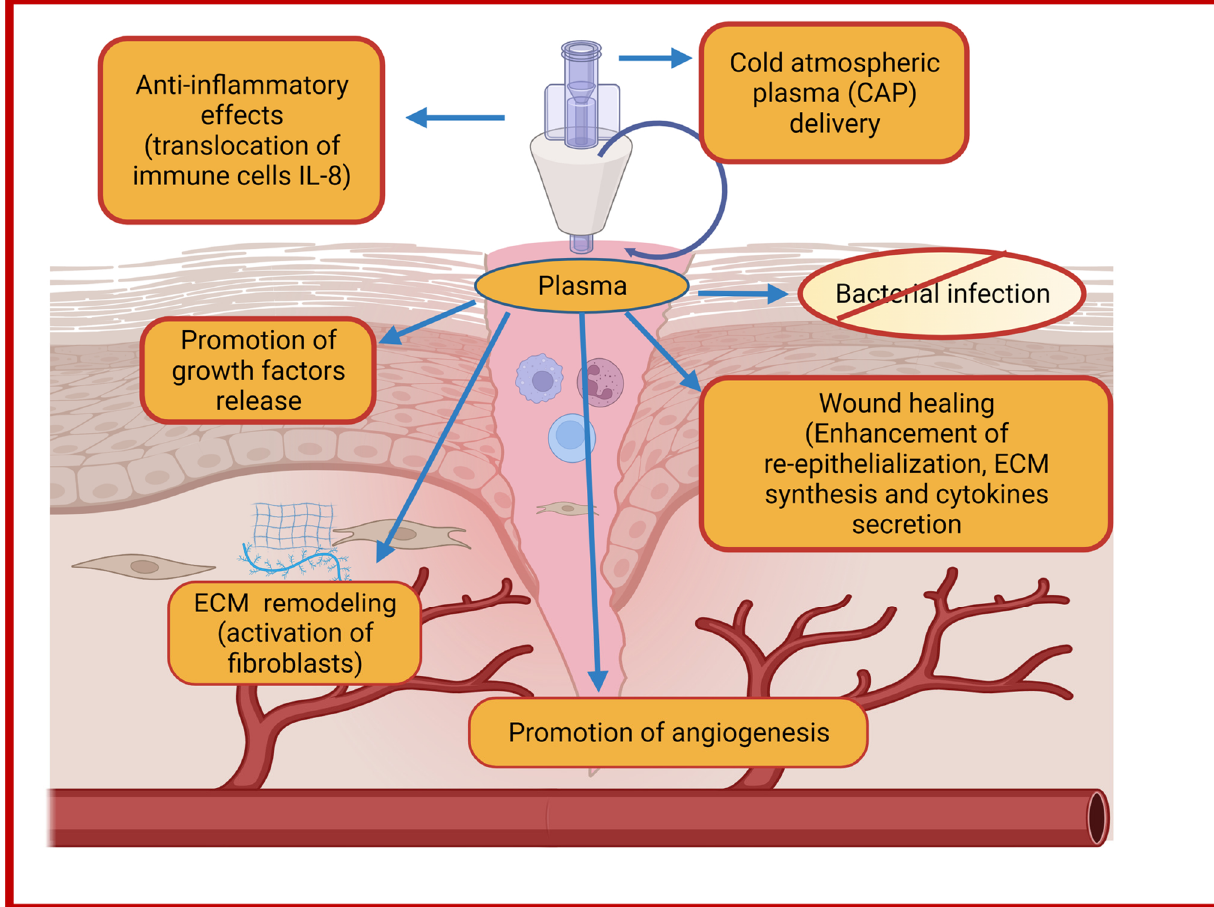
Figure 6. Effects of cold atmospheric plasma (CAP) on wound healing.